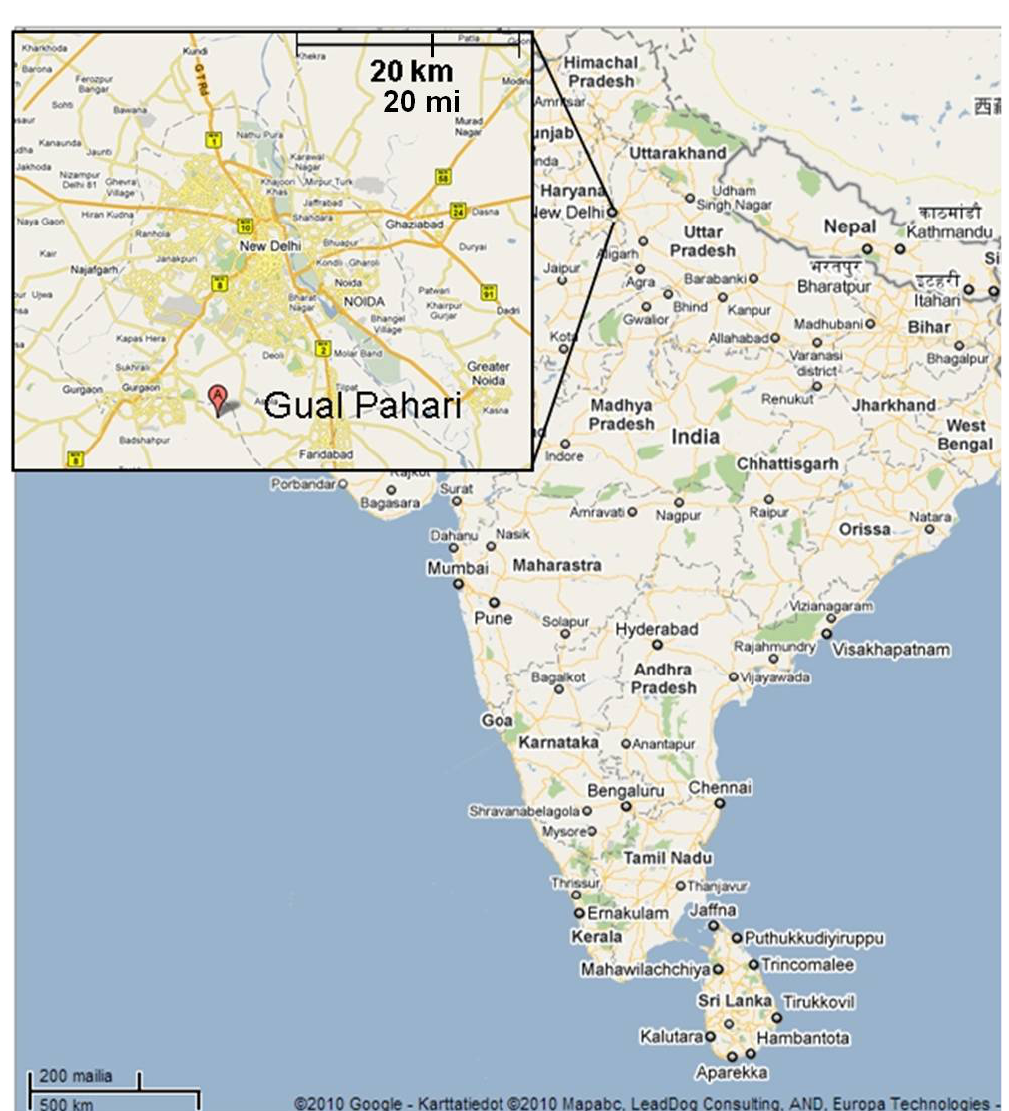
Fig. 1. Location of the Gual Pahari measurement